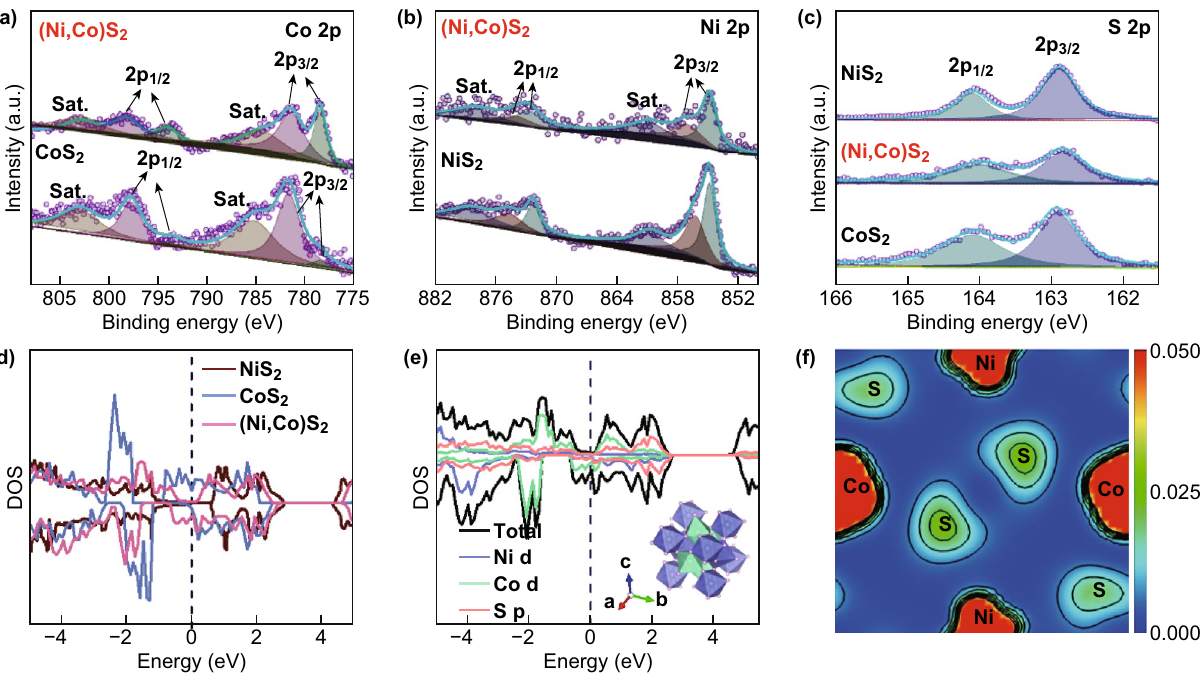
Fig. 2 High-resolution XPS spectra of a Co 2 p , b Ni 2 p , and c S 2 p . d Density of states (DOS) curves of (Ni,Co)S 2 , NiS 2 , and CoS 2 . e Partial density of states (PDOS) curves of (Ni,Co)S 2 . Insert shows the optimized crystal structure of (Ni,Co)S 2 . f Charge density distribution of (Ni,Co)